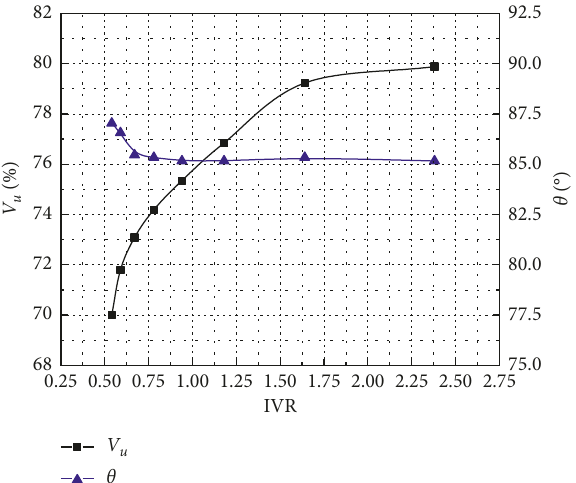
Figure 12: Axial velocity distribution coefficient and weighted-velocity average swirl angle with different IVRs.